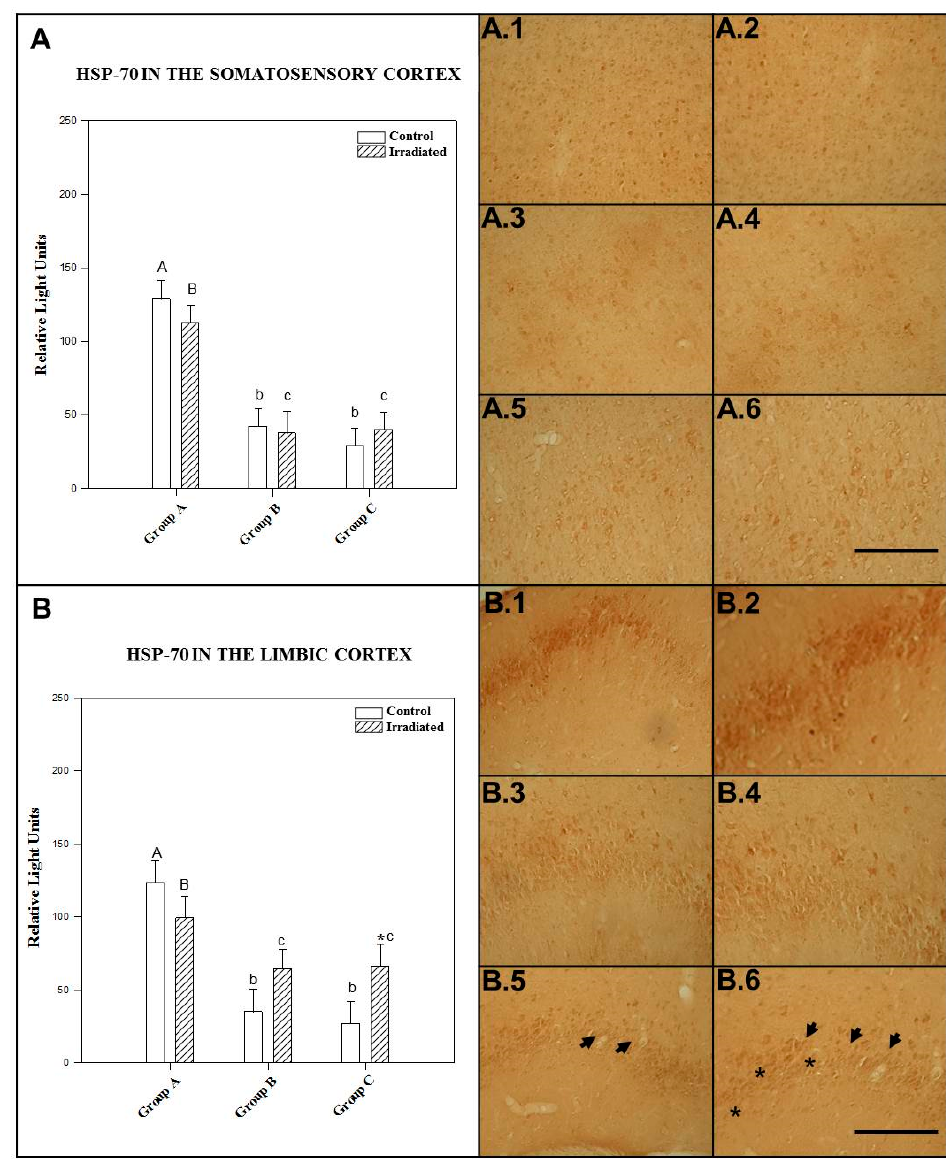
Figure 1. The histograms represent HSP-70 levels detected by ELISA in the somatosensory cortex ( A ) and the limbic cortex ( B ), 1.5 h (Group A) and 24 h (Group B) after acute exposure and 1.5 h after final repeated exposure (Group C) to a 2.45 GHz signal at 0 and 3 W. Each bar represents mean ± SEM ( n = 24 samples/per group). Asterisks (*) indicate statistically significant differences ( p < 0.05) between the irradiated and control for each group. a, b, c indicate statistically significant differences ( p < 0.05) between irradiated or nonirradiated animals comparing between the different groups A, B, C, which were determined using two-way ANOVA followed by the Holm-Sidak test for multiple comparisons The photographs show the HSP-70 immunomarkers for groups A, B and C in the somatosensory cortex, control (A.1, A.3 and A.5) and irradiated animals (A.2, A.4 and A.6); in the limbic cortex, control (B.1, B.3, B.5) and irradiated animals (B.2, B.4, B.6) ( n = 15 samples/per group). In the photographs it is indicate with the arrowhead and asterisk that means increase on regional cytolocalization. Scale bar = 60 µm.